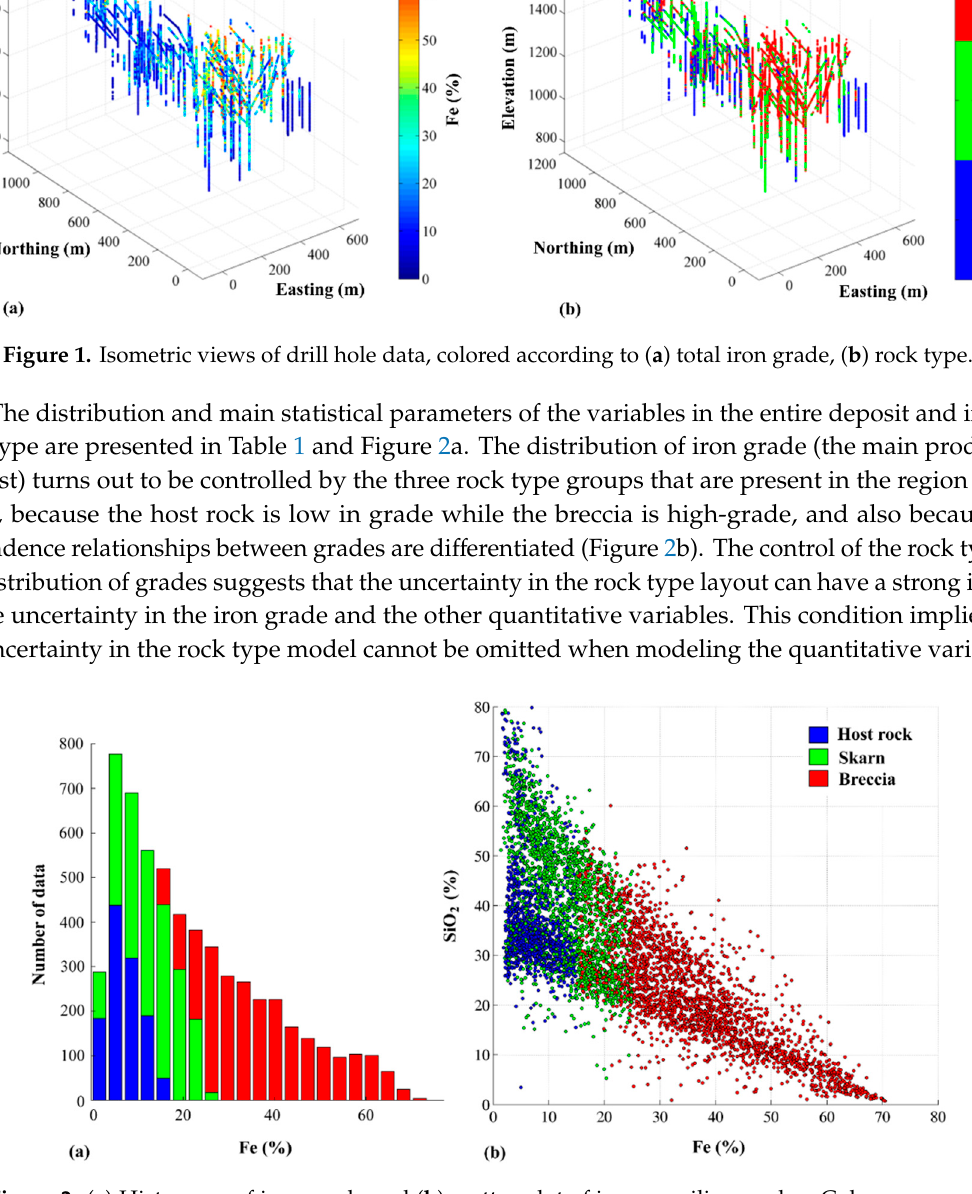
Figure 2. ( a ) Histogram of iron grade and ( b ) scatter plot of iron vs. silica grades. Colors represent rock types.